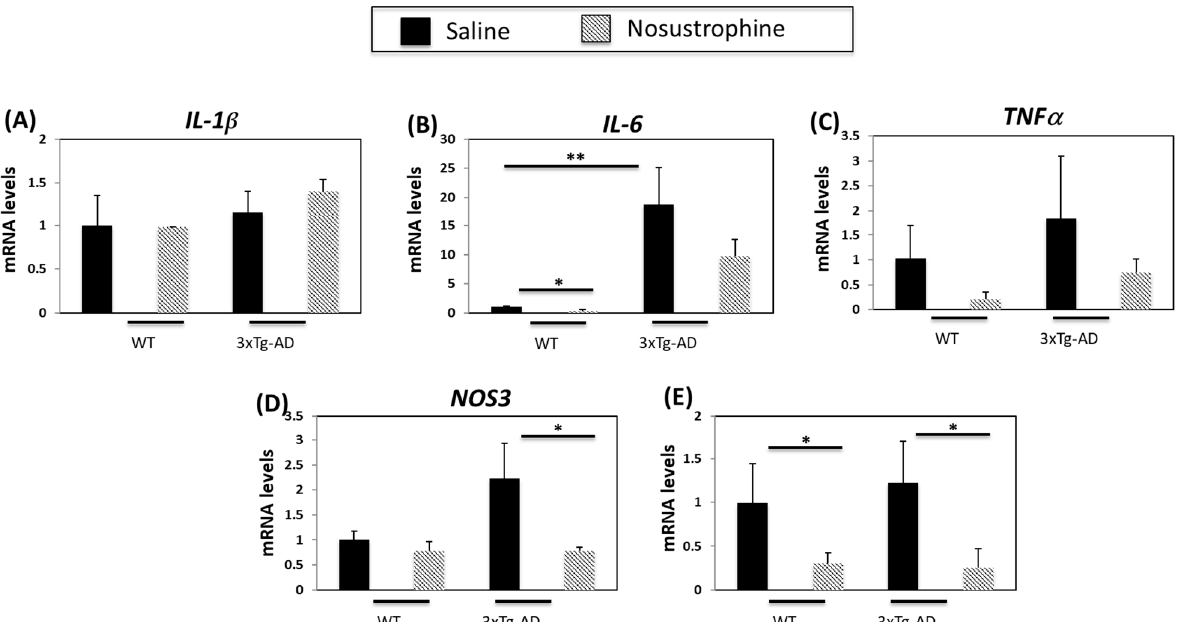
Figure 6. Nosustrophine regulates inflammation-related gene expression in young (3–4-month-old) AD mice. IL-1 β ( A ), Il-6 ( B ), TNF α ( C ), NOS3 ( D ) and COX-2 ( E ) mRNA levels were measured by qPCR in hippocampus from wild-type and 3xTg-AD mice ( n = 4 animals per group). Results are expressed as fold induction vs. saline-treated wild-type- or trigenic mice. Data are expressed as means ± S.E.M. * p < 0.05, ** p < 0.01.